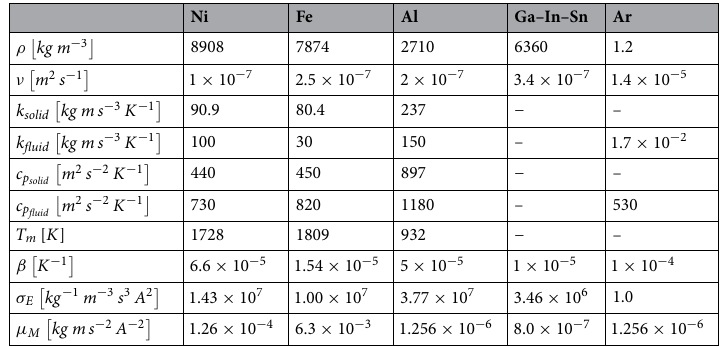
Table 1. Thermo-physical properties used in the thermal-fluid dynamics simulations 35–39